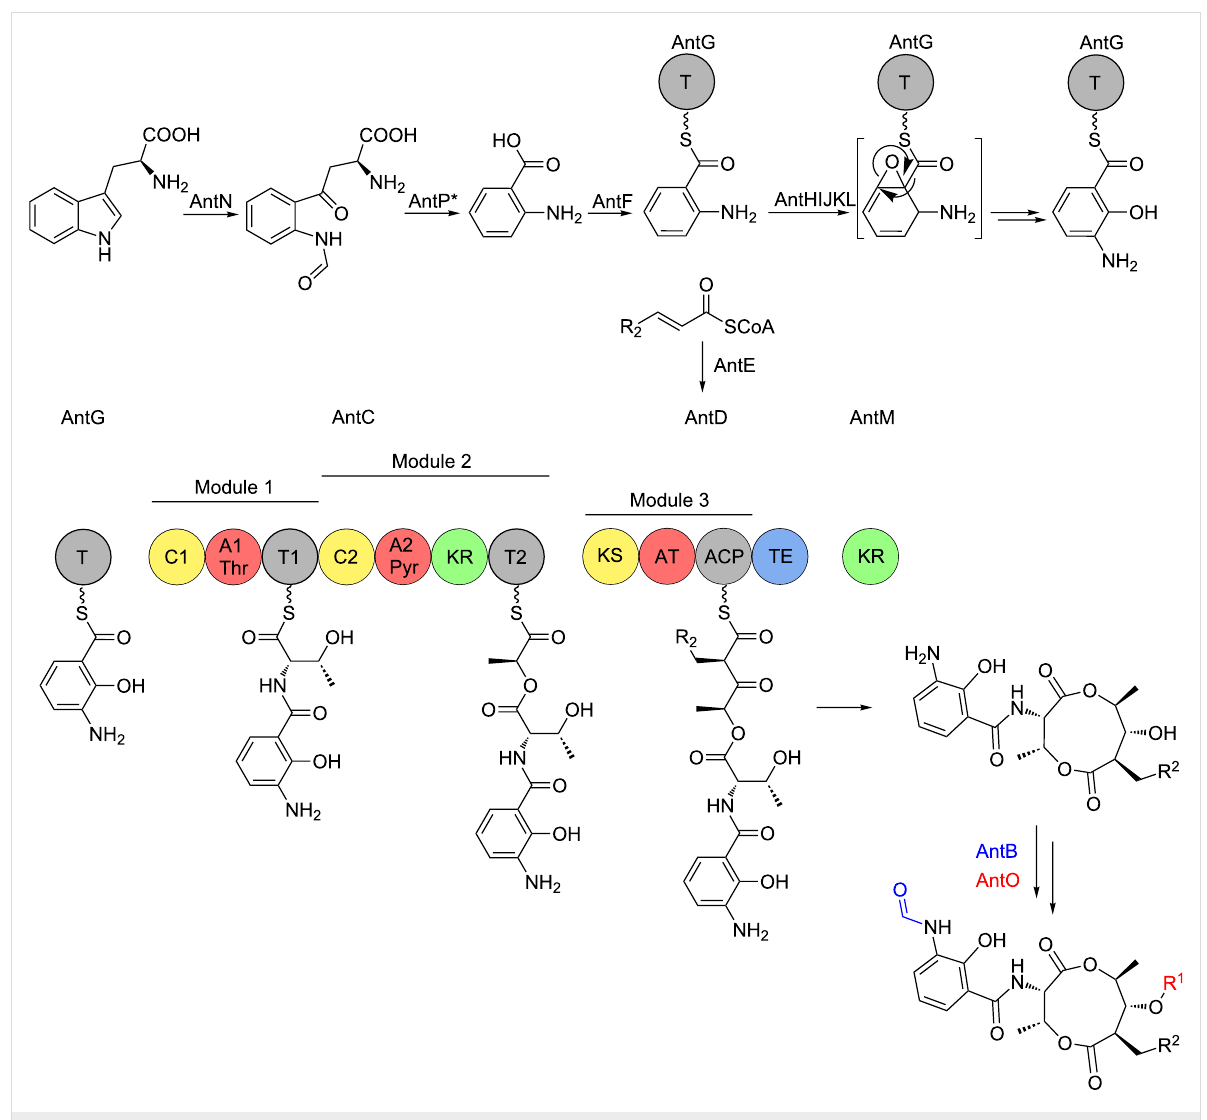
Figure 3: Proposed biosynthetic pathway for antimycins. The antimycin biosynthetic pathway is described in detail in the text. C = condensation; A, adenylation; T, thiolation; KR, ketoreduction; KS, ketosynthase; AT, acyltransferase; ACP, acyl carrier protein; TE, thioesterase; *AntP is a pathway- specific kynureninase that is encoded by L- and I-form ant gene